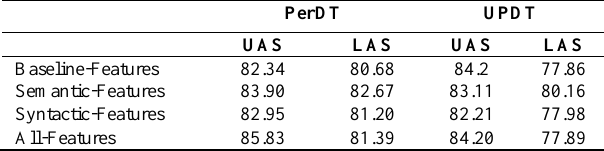
Table 5. Projective-Second-Order.